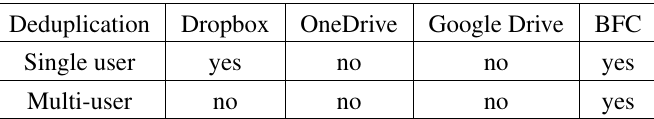
Table 1. Deduplication